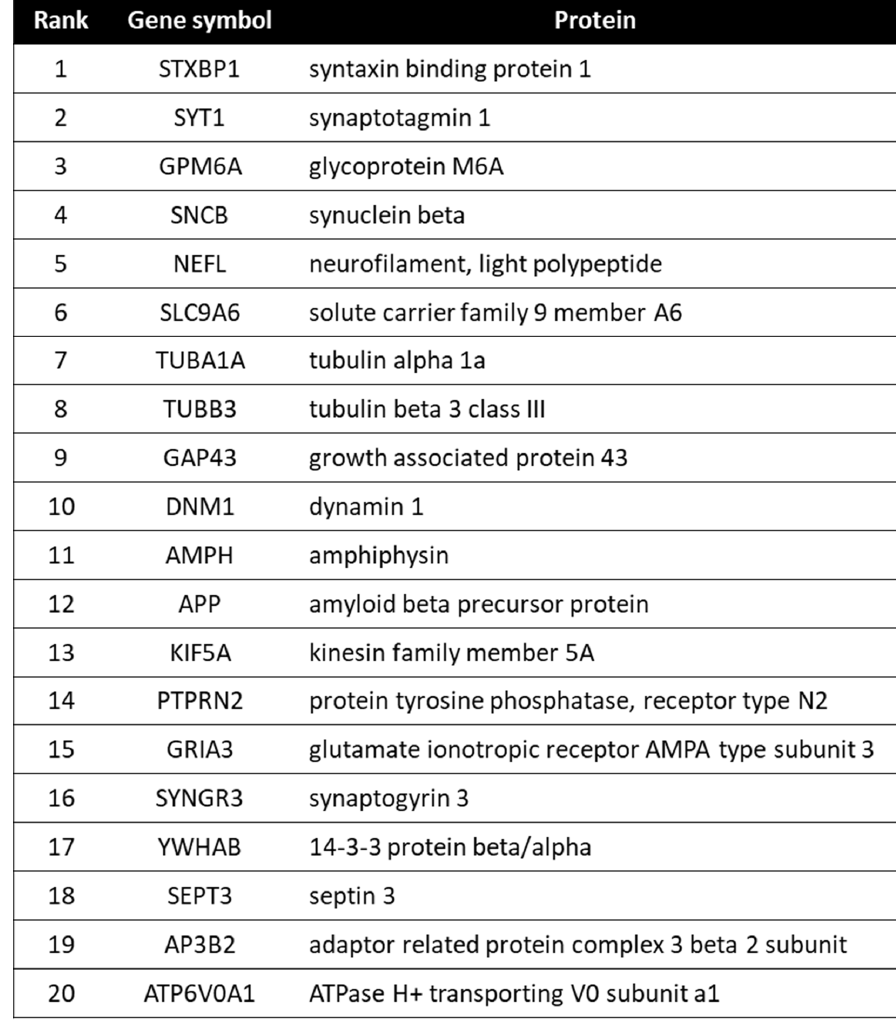
Figure 3. Gene ontology enrichment analysis and pathway analysis. ( A ) Up- or downregulated genes with fold-changes > 1.5 were analyzed by the Database for Annotation, Visualization and Integrated Discovery (DAVID, version 6.8) for gene ontology (GO) enrichment analysis. ( B ) Up- and downregulated genes with fold-changes > 1.5 were analyzed by Kyoto Encyclopedia of Genes and Genomes (KEGG) pathway enrichment analysis. ( C ) A network analysis of upregulated (2.50–5.42-fold) and downregulated (0.22–0.66-fold) genes between control and Kii ALS / PDC samples, as performed with GeneMANIA. The top 20 genes identified as being upstream of di ff erentially expressed genes in Kii ALS/PDC samples compared with control samples.